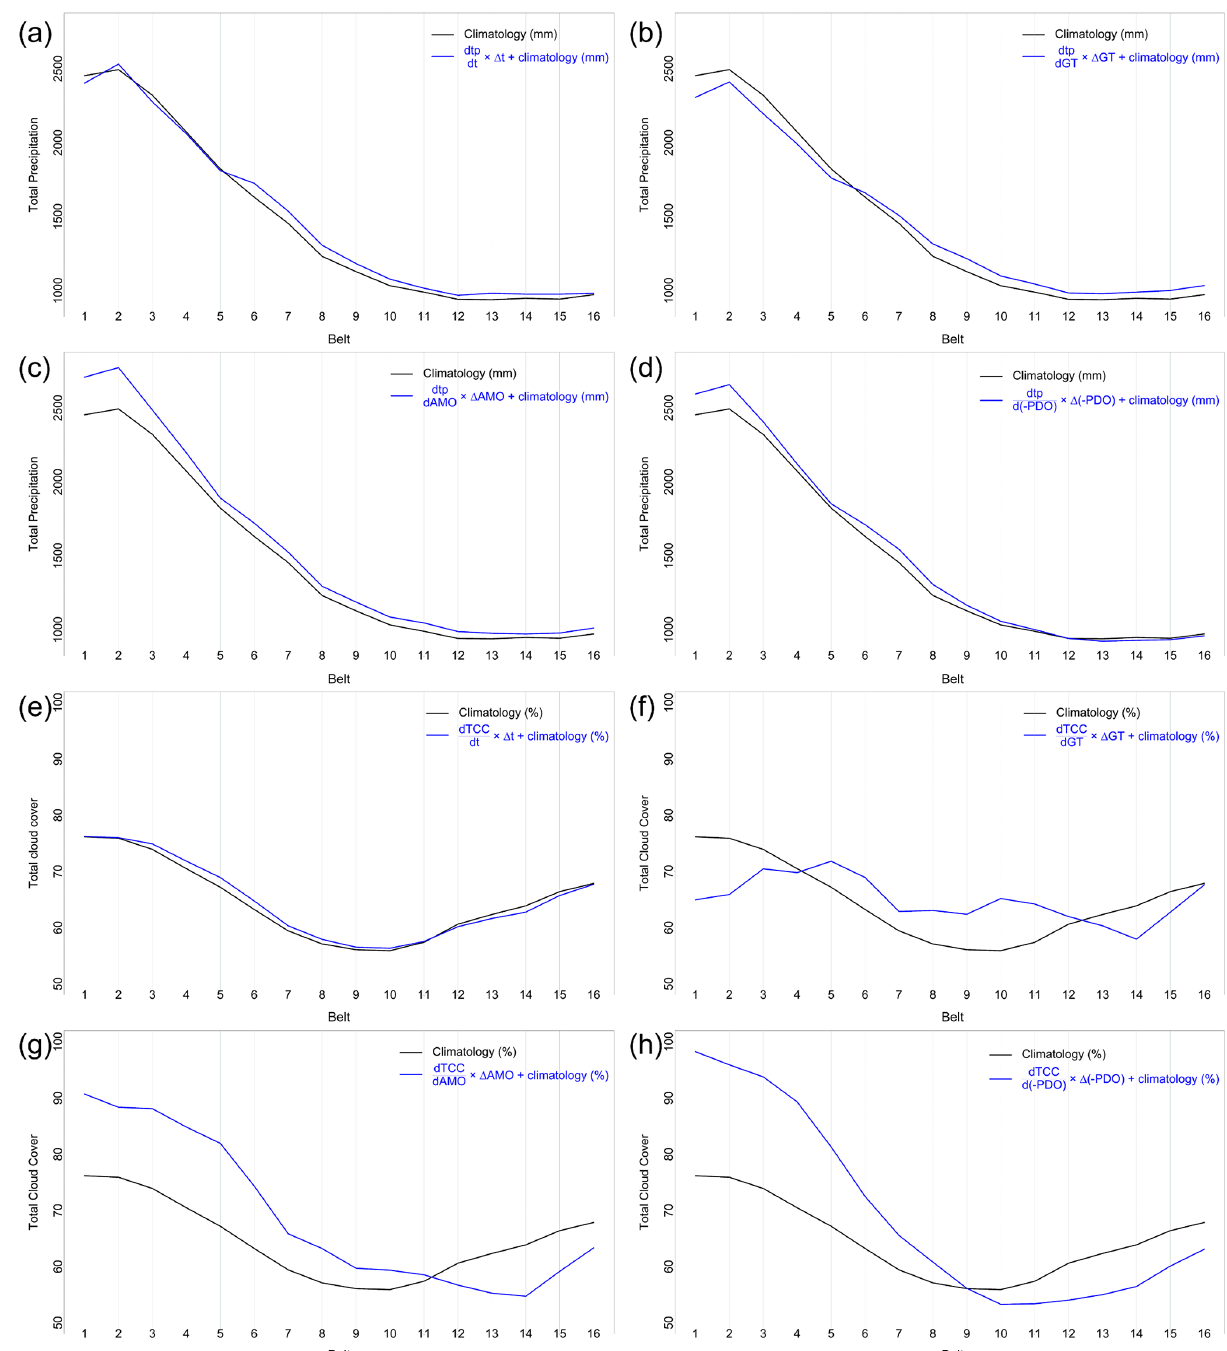
Figure 3. Changes (blue curve) from the climatology (black) during the period 1983–2009 in the annual total precipitation (mm) in the 16 belts of Fig. 2 as a function of time (a) , global temperature (b) , AMO (c) and PDO (d) . Changes from the climatology in the annual total cloud cover (%) in the 16 belts of Fig. 2 as a function of time (e) , global temperature (f) , AMO (g) and PDO (h) . The formula for calculating the blue curve, for instance for the changes in precipitation as a function of global temperature (b) , is d ( TP )/ d ( GT ) · (cid:49) GT, where (cid:49) GT denotes the difference in the global temperature between 1983 and